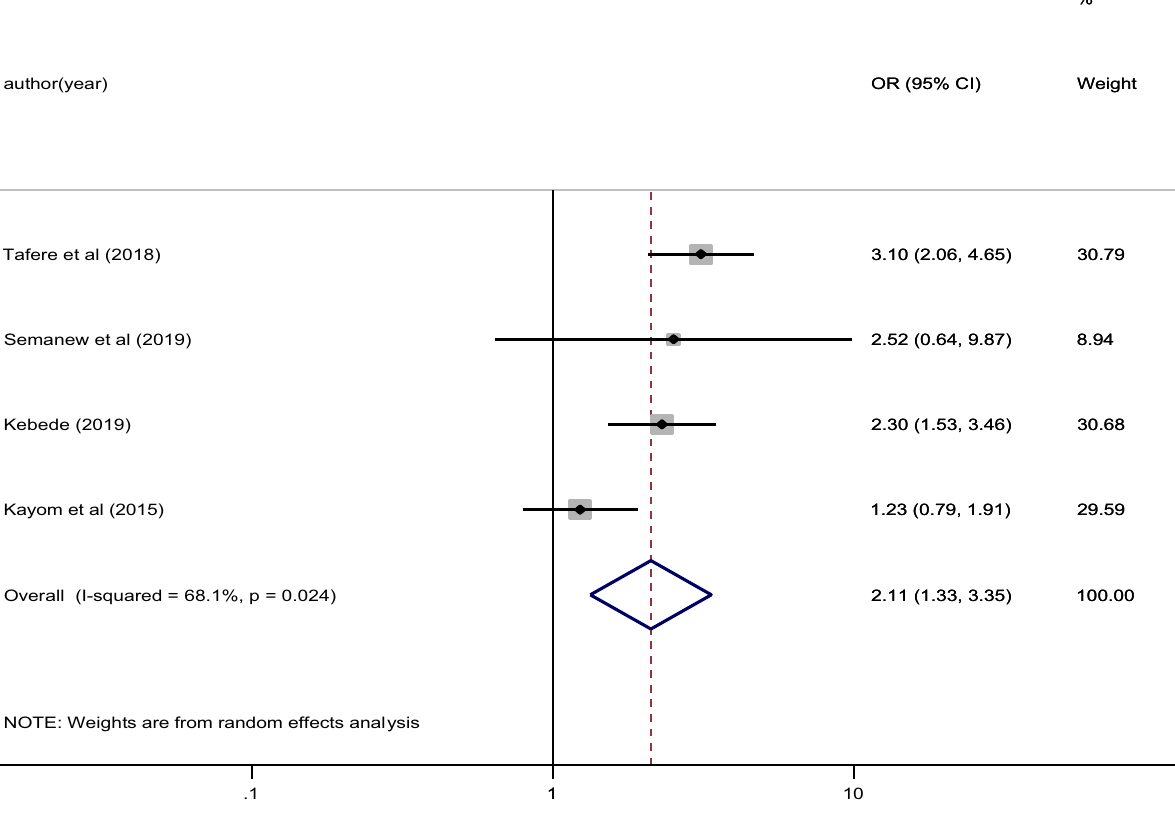
Figure 5. The pooled effect of four or more ANC follow up on essential newborn care practice in East